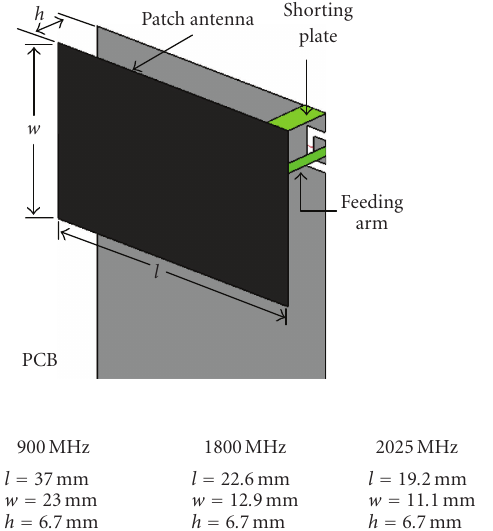
Figure 3: The numerical structure of the rectangular patch antenna with shorting plate, used for the handset with internal antenna, and its dimensions at 900, 1800, and 2025